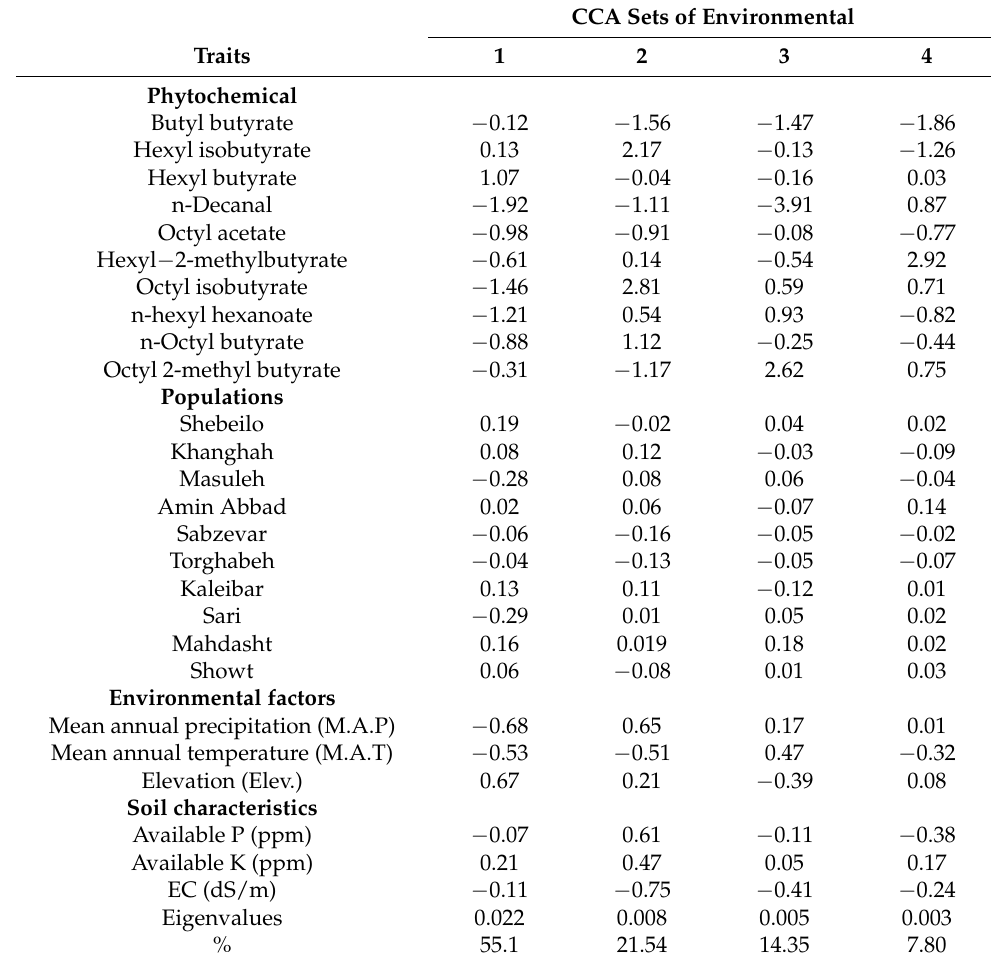
Table 3. Canonical coefficients, eigen-values, estimated and cumulative variance for four CCA sets between phytochemicals with environmental